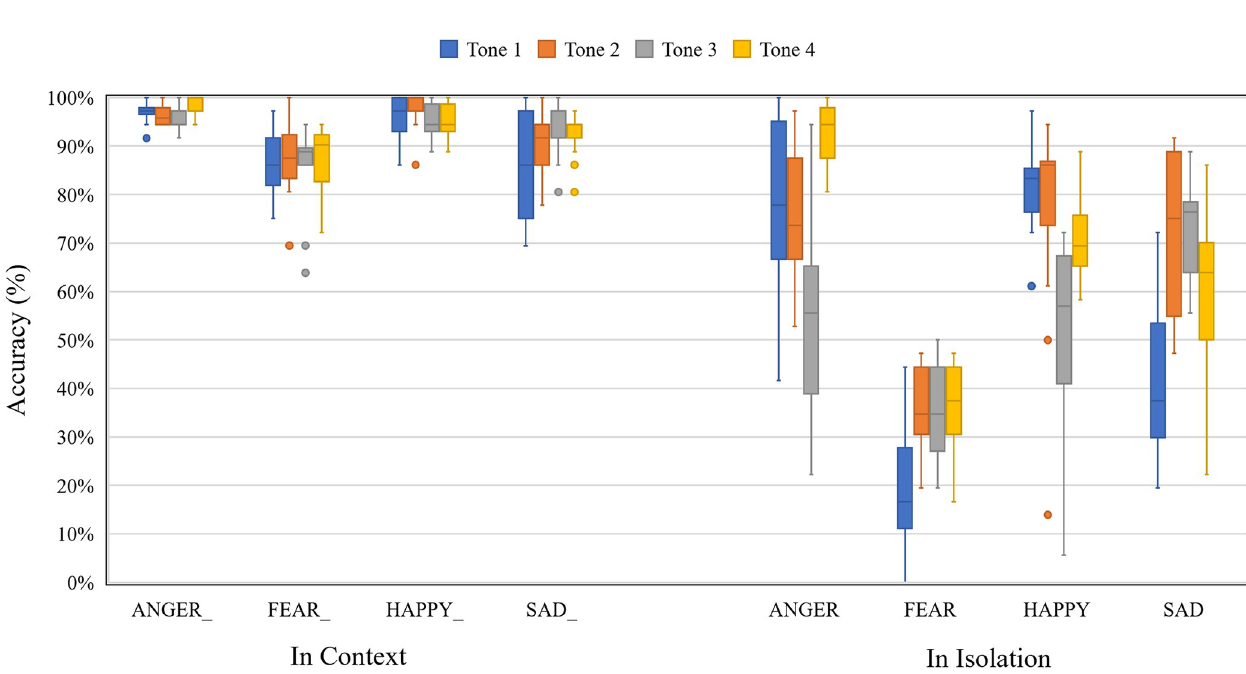
Fig 7. Boxplot showing the emotion recognition accuracy as a function of Mandarin tone and context.